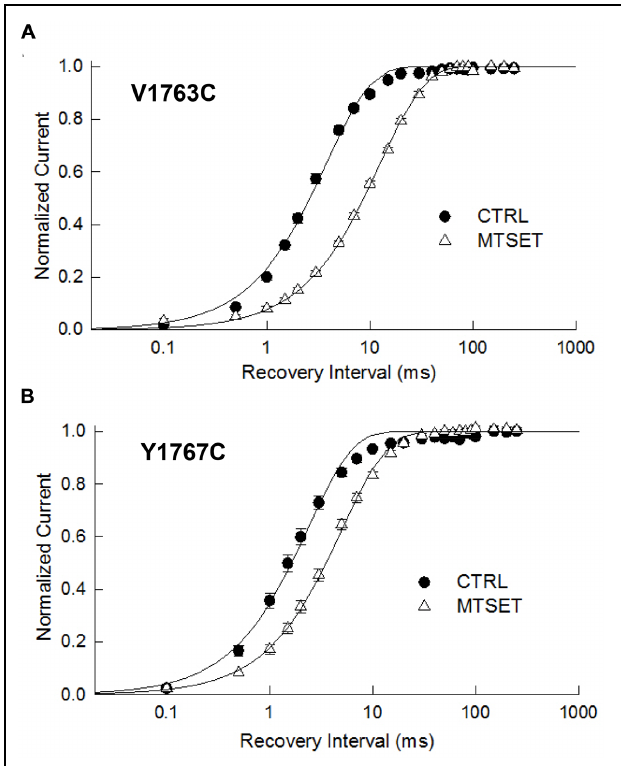
FIGURE 4 | Methanethiosulfonate reagent slows recovery from inactivation. Depolarizing prepulses to –10 mV for 20 ms were used to the V1763C (A) and Y1767C (B) mutant channels. Cells were returned to –140 mV for a variable interval (0.1 ms–250 ms) before applying a standard test pulse to –10 mV for 20 ms. The test currents were normalized to the recovery measured after 250 ms of recovery and plotted versus the recovery interval. The smooth lines are biexponential curve fits with time constants and relative amplitudes of the fast components listed in Table 1 .